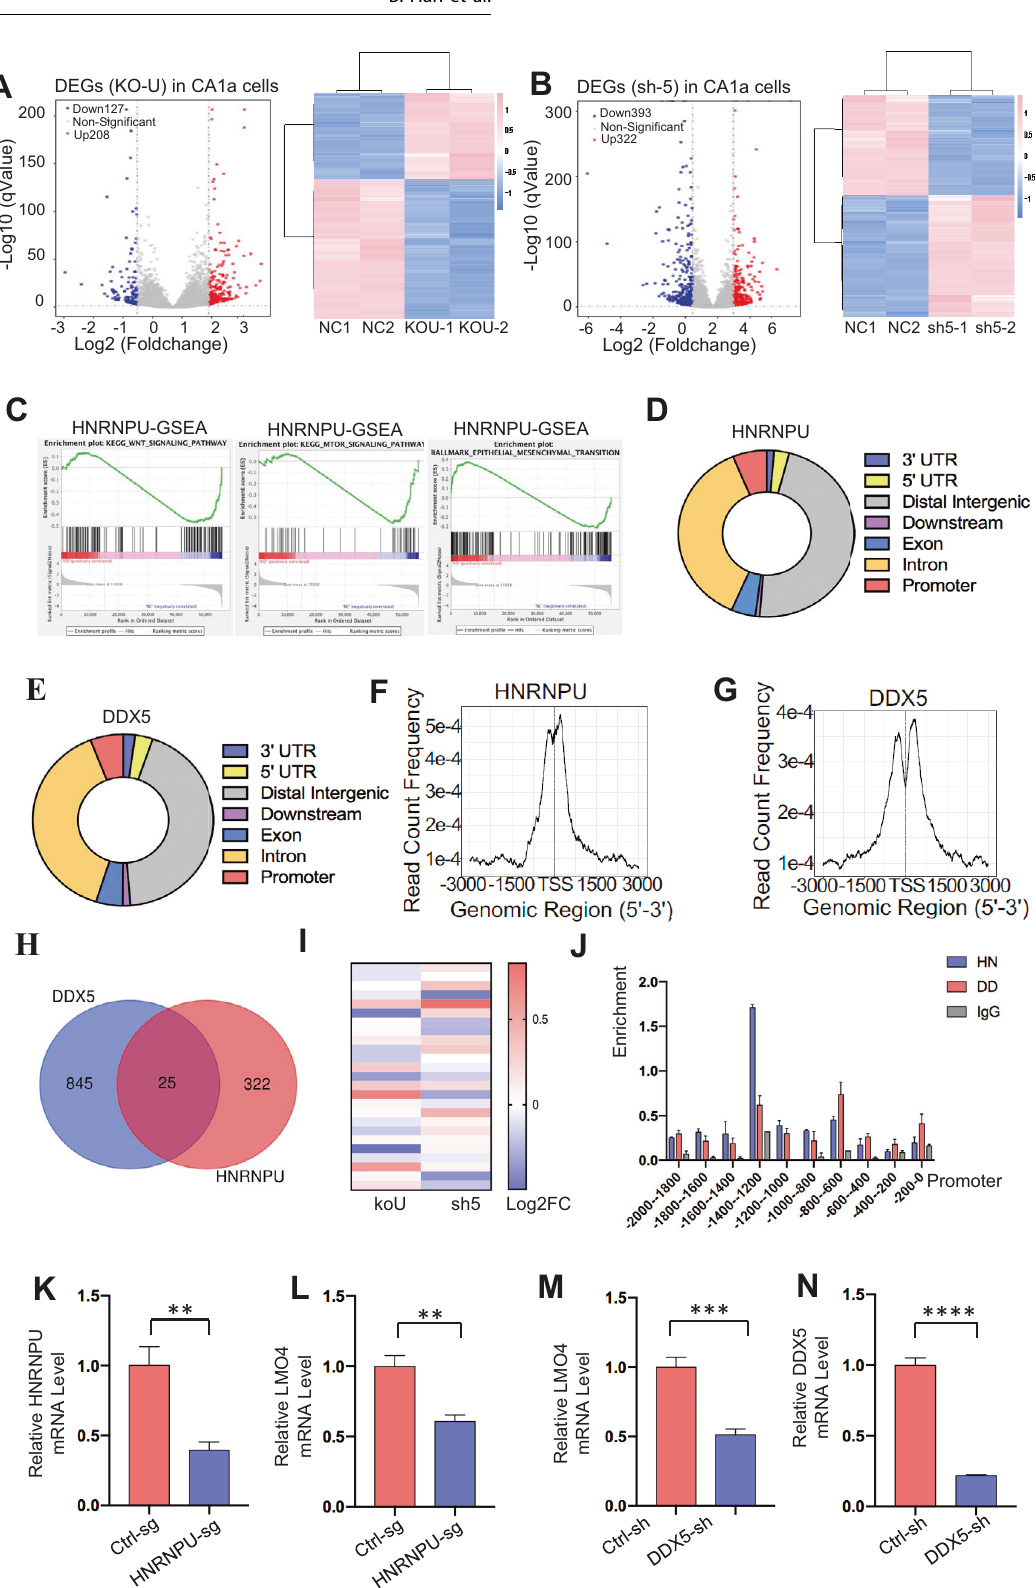
enriched in the TSS of LMO4 and then activate LMO4 transcrip- tion. These results explained the mechanism by which LMO4 expression is activated. Regarding how LMO4 functions when it is upregulated, Ning Wang et al reported that LMO4 promoted the Cell Death and Disease (2022)